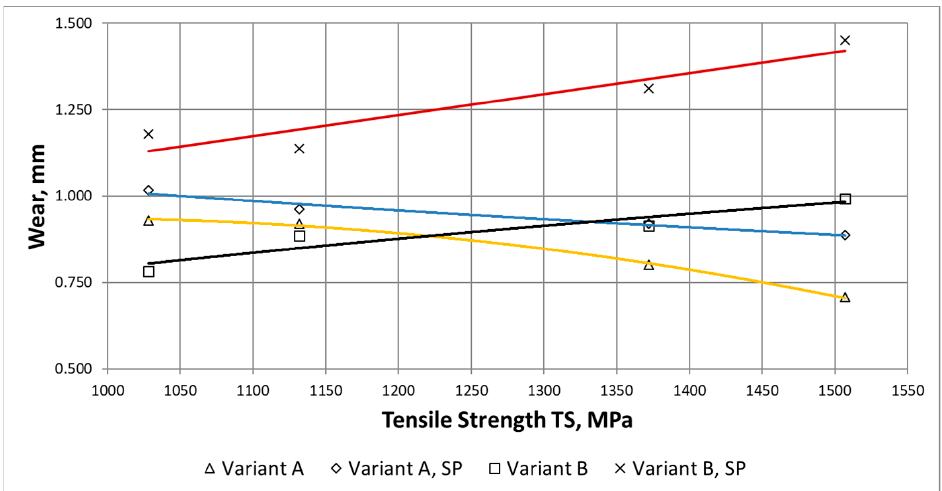
Figure 12. Waveforms of the wear parameter δ MAX as a function of the maximum strength, deter- mined for the variants of wear and dynamic treatment of the considered ADI.